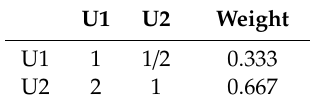
Table A11. Pairwise comparison matrix of rural use indicators.